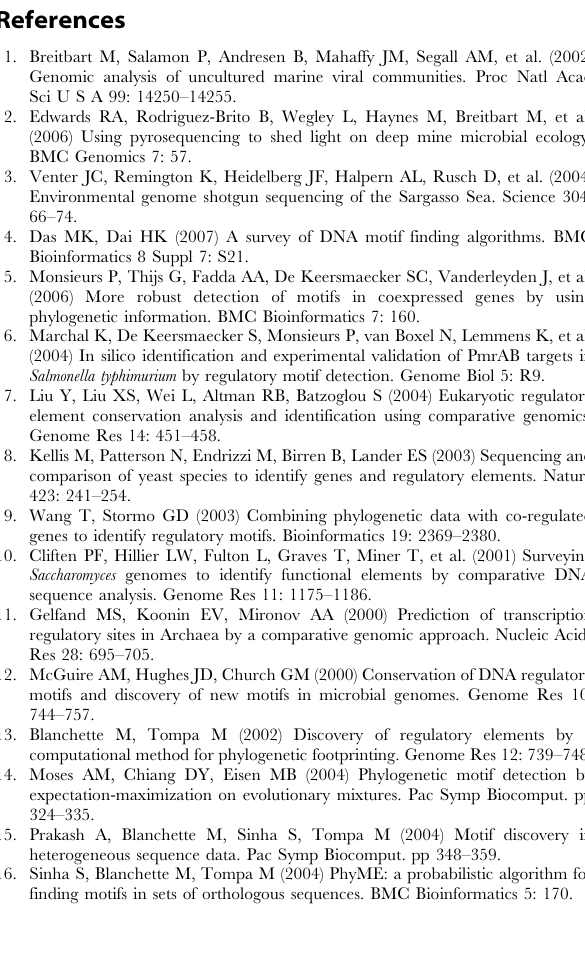
Table S8 Table S8 consists of Tables S8 (A and B) containing the results of PG, PS and MEME in the orthologous